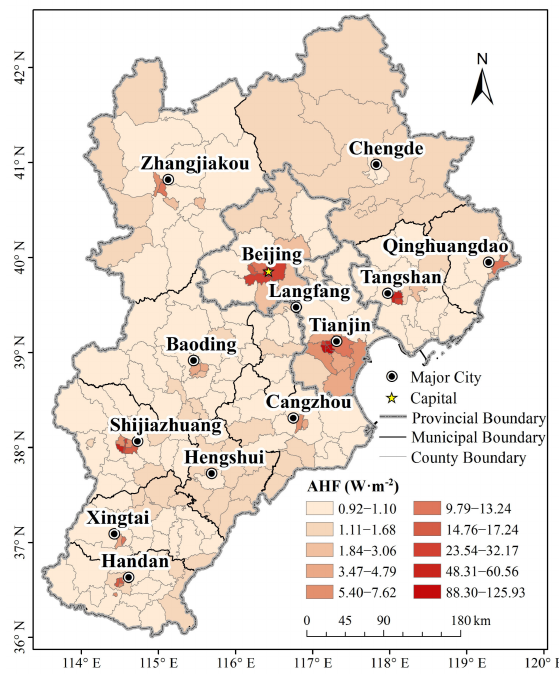
Figure 4. The annual mean AHF of each county in the Beijing–Tianjin–Hebei region in the year 2015. In order to quantitatively analyze the difference between the AHF value in urban areas and that in suburbs, a prefecture-level AHF was obtained from the county-scale AHF. Then the average AHF values of the districts (i.e., urban area) and counties (i.e., suburbs) in the cities of each municipality were calculated respectively (Table 1). The districts are the areas with a high degree of urbanization that are geographically located within the central city. Conversely, the counties are geographically far away from the city’s center. The AHF value of an urban area is related to the city scale. The highest AHF value is in the urban area of Tianjin municipality with 39.21 W · m − 2 , and the smallest is in Chengde city with 1.02 W · m − 2